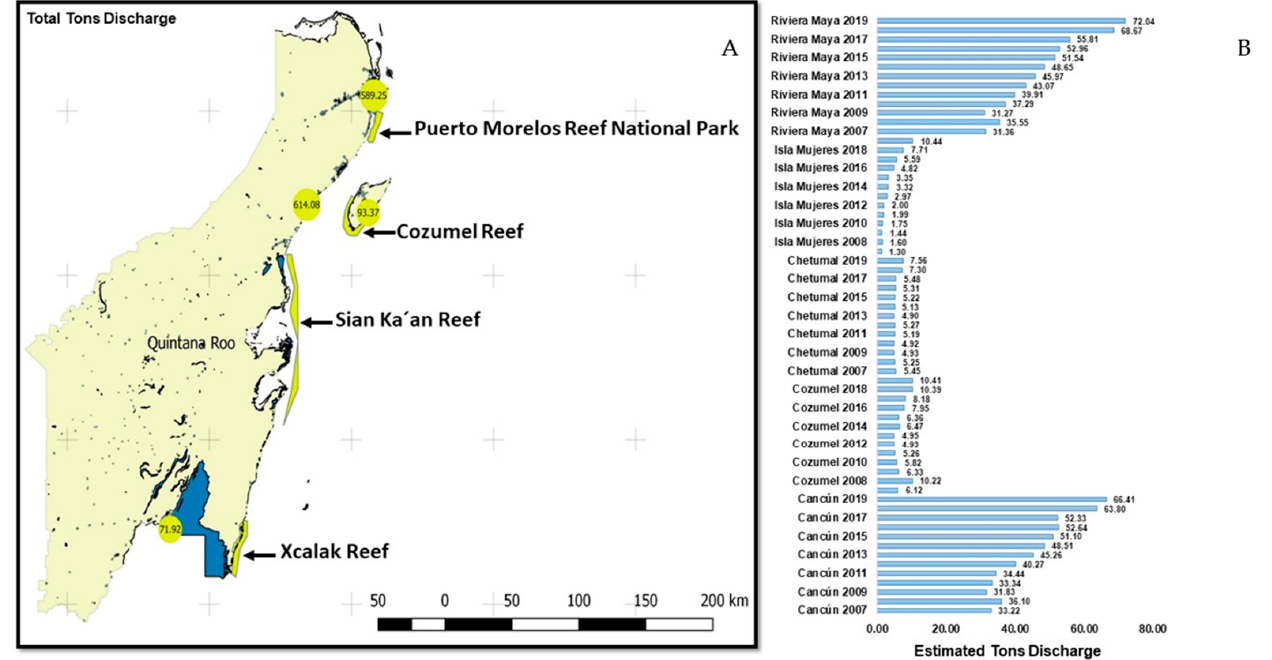
Figure 2. Estimation of the total discharge of sunscreen (TDS) in the five main tourist destinations of Quintana Roo, México, over the last 12 years. ( A ) Total discharge of sunscreen in four important reef areas of Quintana Roo, México. ( B ) Total discharge of sunscreen from 2007 to 2019 in the five principal tourism states of Quintana Roo.